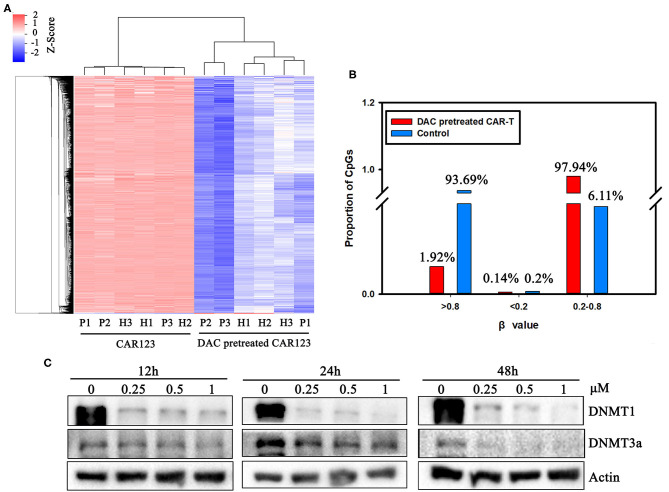
The divergence of DNA methylation landscape between CD123 CAR-T cells pretreated with and without DAC. (A) CD123 CAR-T cells from three patients (P1, P2, P3) and three healthy donors (H1, H2, H3) were treated with or without 1 μM DAC for 48 h. Illumina Infnium HD Methylation 850 K arrays were used to determine the DNA methylation status. Differential methylation CpG sites whose case Diffscore < −13 or >13 (p < 0.05) and case Delta_Beta >0.17 or < −0.17 were presented. (B) Percentage of high (β-values >0.8), medium (0.2 < β-values <0.8) and low (β-values <0.2) methylation level was presented with or without DAC pretreatment. (C) CD123 CAR-T cells from patients were treated with a series of doses of DAC for 12, 24, or 48 h. Whole-cell lysates were subjected to western blotting analysis to examine the protein levels of total DNMT1 and DNMT3a. β-actin was used as loading control. The data are representative of three determinations with identical results.